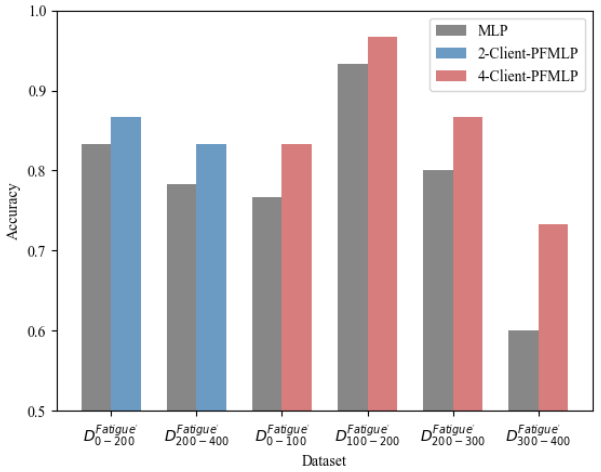
Figure 12. Accuracy comparisons among single-node MLP, 2-client and 4-client PFMLP on the fatigue